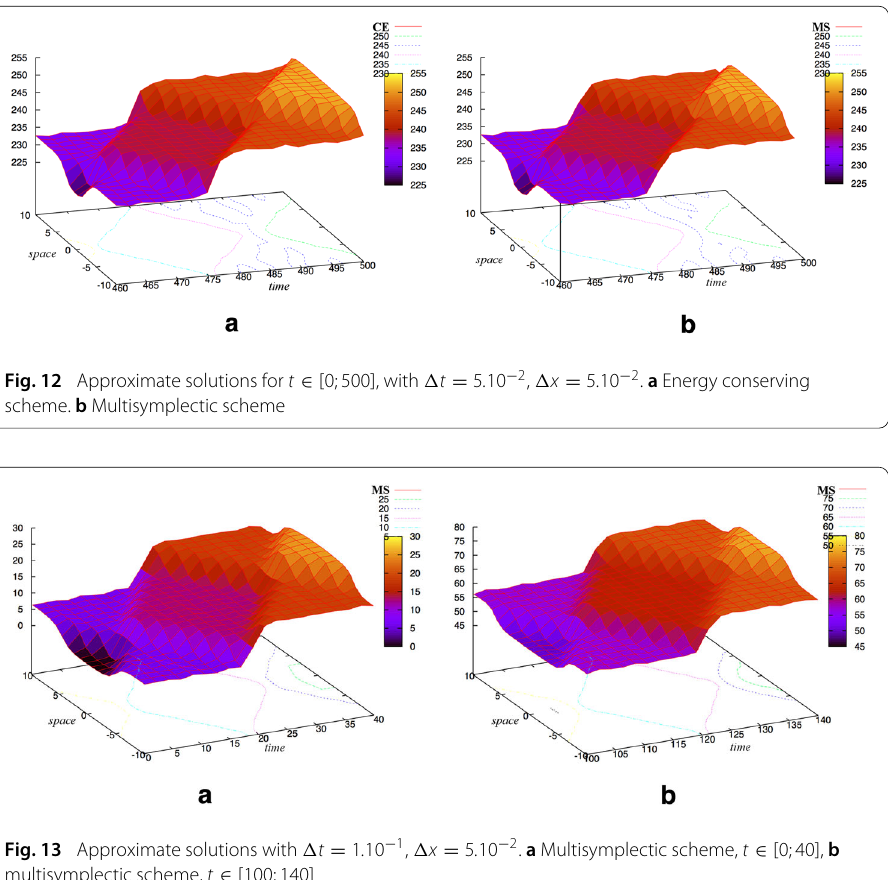
Fig. 13 Approximate solutions with (cid:7) t = 1 . 10 − 1 , (cid:7) x = 5 . 10 − 2 . a Multisymplectic scheme, t ∈ [0;40], b multisymplectic scheme, t ∈